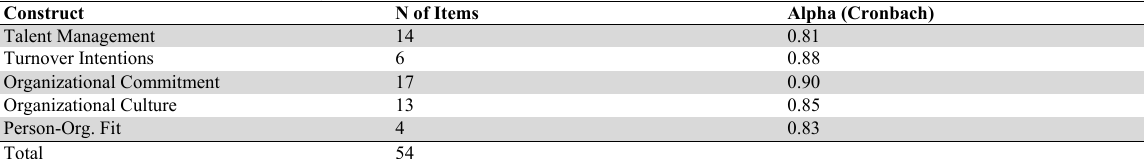
Reliability and Internal Consistency